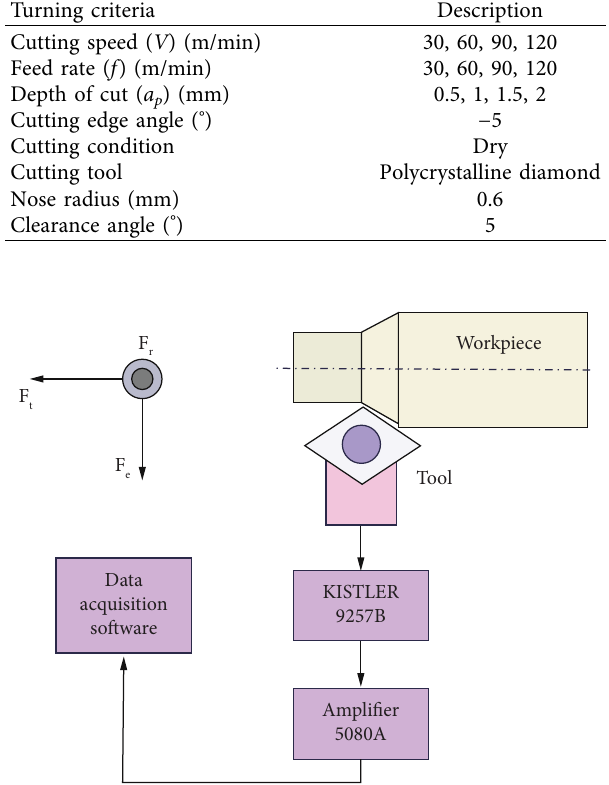
Figure 1: Illustration of cutting force